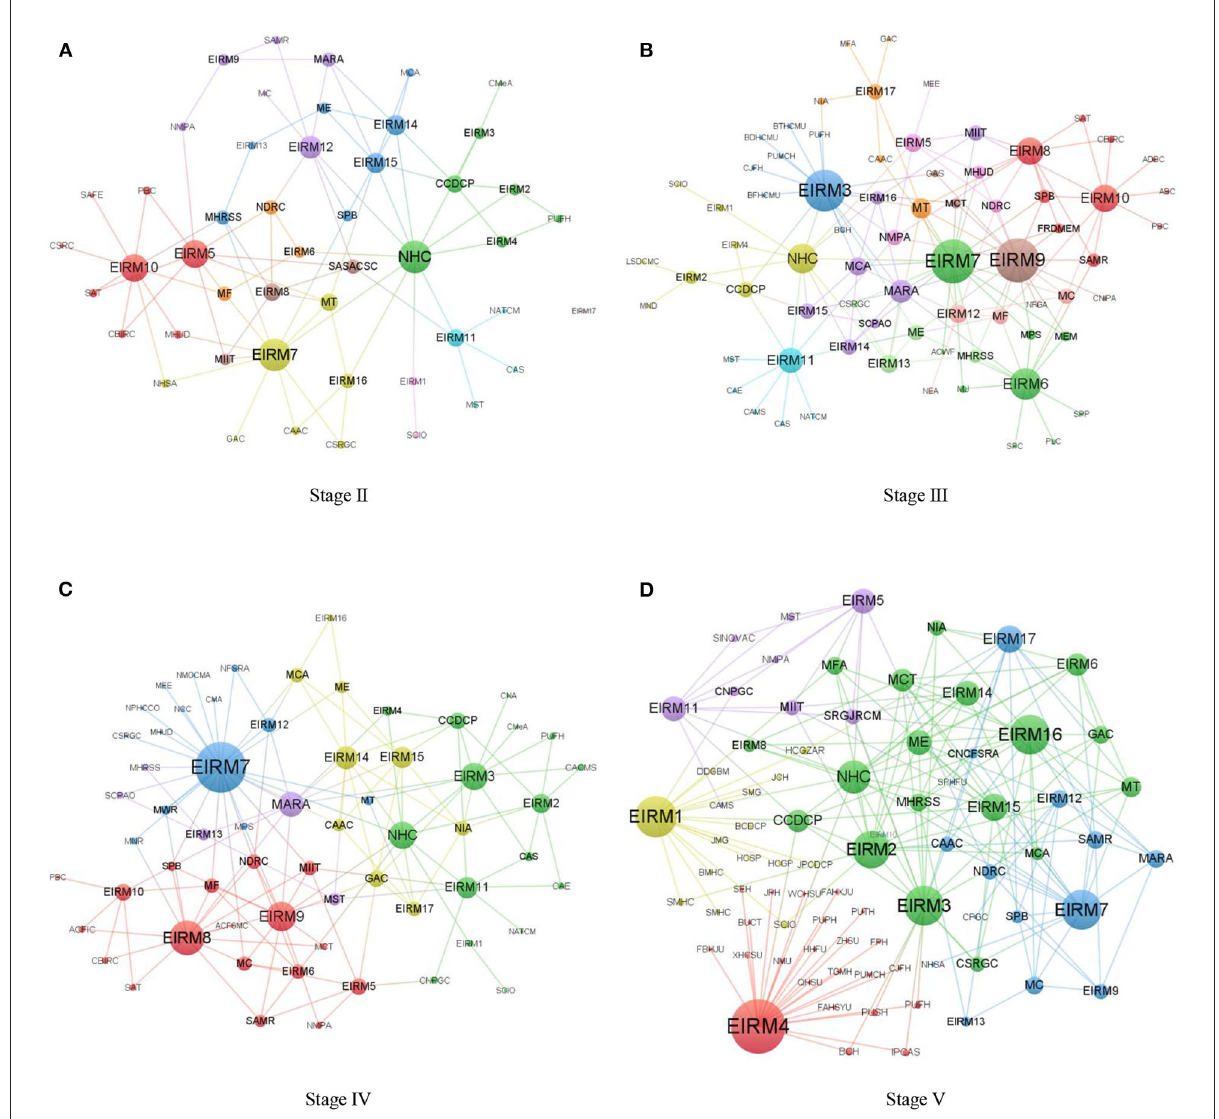
FIGURE3 EOs-EIRMs 2-mode networks of Stages II-V. (A) Stage II, (B) Stage III, (C) Stage IV, and (D) Stage